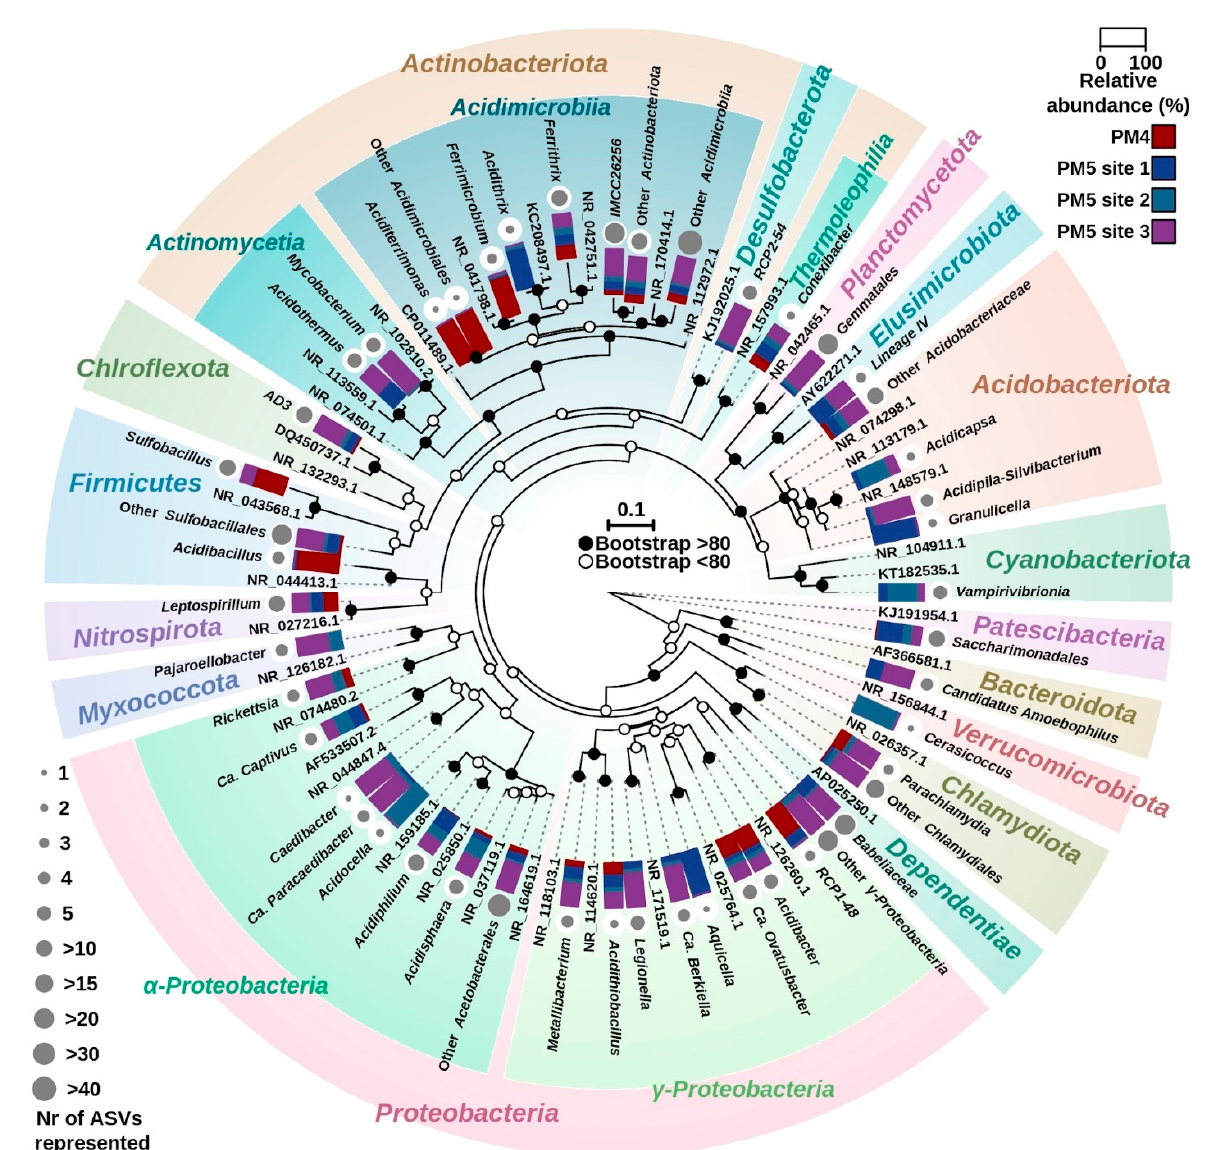
Figure 7. Maximum likelihood phylogenetic tree based on 16S rRNA gene sequences of bacteria from sites PM4 and PM5 (PM5.1, PM5.2 and PM5.3), Parys Mt. Relative abundance (%) of reads assigned to taxonomic groups found on each site are shown in the rectangles attached to respective groups. Taxonomic groups correspond to the sum of all ASVs by lineage and make groups, taking one ASV sequences as representative and highlighting the number of ASVs in the groups through the size of the circle next to it on the tree. The number of ASVs assigned to each represented group is shown by the size of the grey circle next to each label. Bootstrap score is shown by open (< 80) or filled (> 80) circles for each node. Scale bar, 0.1 substitutions per position.